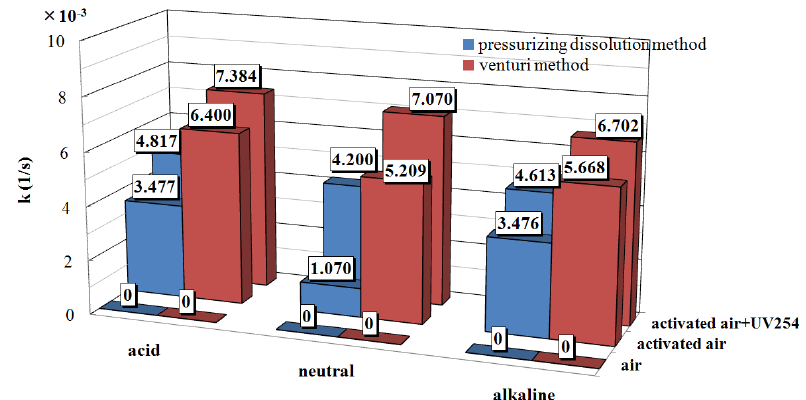
Fig. 10 Effects of UV irradiation and microbubble generator type on decolorization performance for various solution pH.